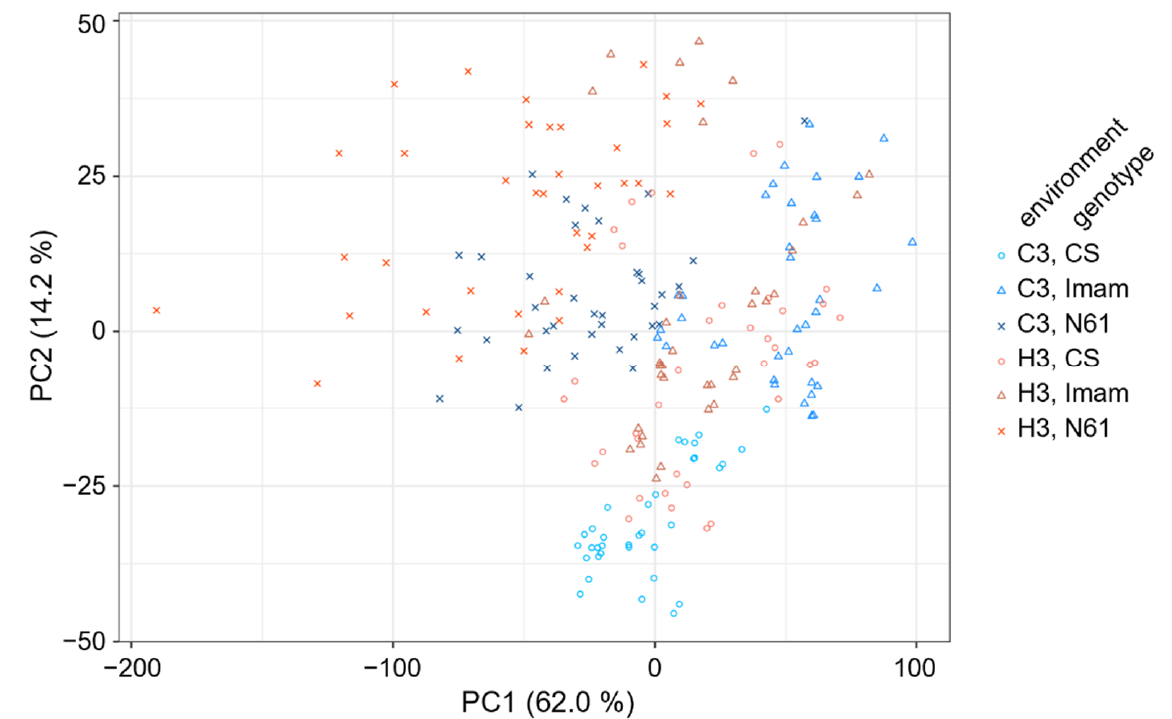
Figure 3. Score plot of principal component analysis showing the distribution of FTIR spectra for three wheat genotypes under two environmental conditions. Symbols for the three genotypes and two environments are shown at the right of the panel.